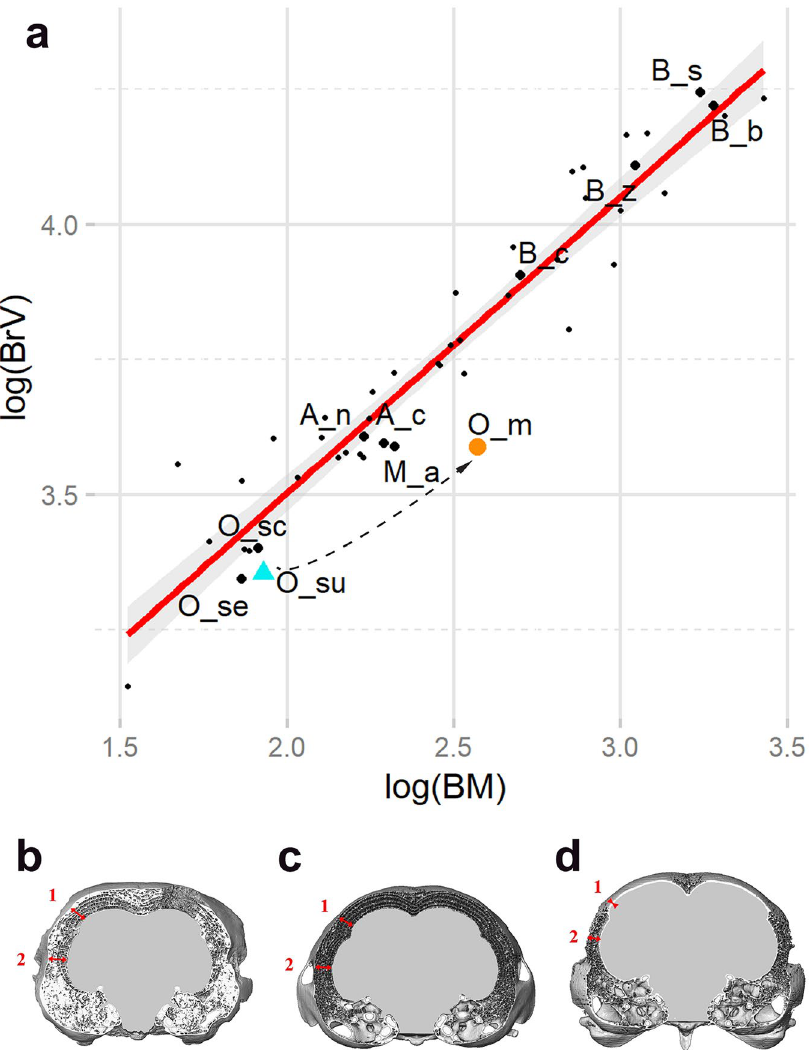
Figure 3. ( a ) Scatter plot of LOG brain volume to LOG body mass (present study data together with published strigid data 21 ). O. murivorus (orange circle) exhibits the lowest ratio brain volume/body mass of all owls. Dashed arrow shows the evolutionary trajectory from O. sunia (green–blue triangle) to O. murivorus , which strongly deviates from the allometric trend (Y/X regression line; r 2 = 0.91). Slope = 0.55. The translucid grey zone represents a 95% confidence interval around the regression. Dashed arrow symbolizes evolutionary trajectory from O. sunia to O. murivorus . ( b )–( d ), Transverse section of 3 skulls in 3D volume at level of foramen magnum, showing the minimal thickness of cranium wall as measured (red arrows) in the wulst (1) and cerebral hemisphere (2) regions, relative to cranium width. ( b ), O. murivorus ; ( c ) O. sunia ; ( d ) O. scops . Not to scale.